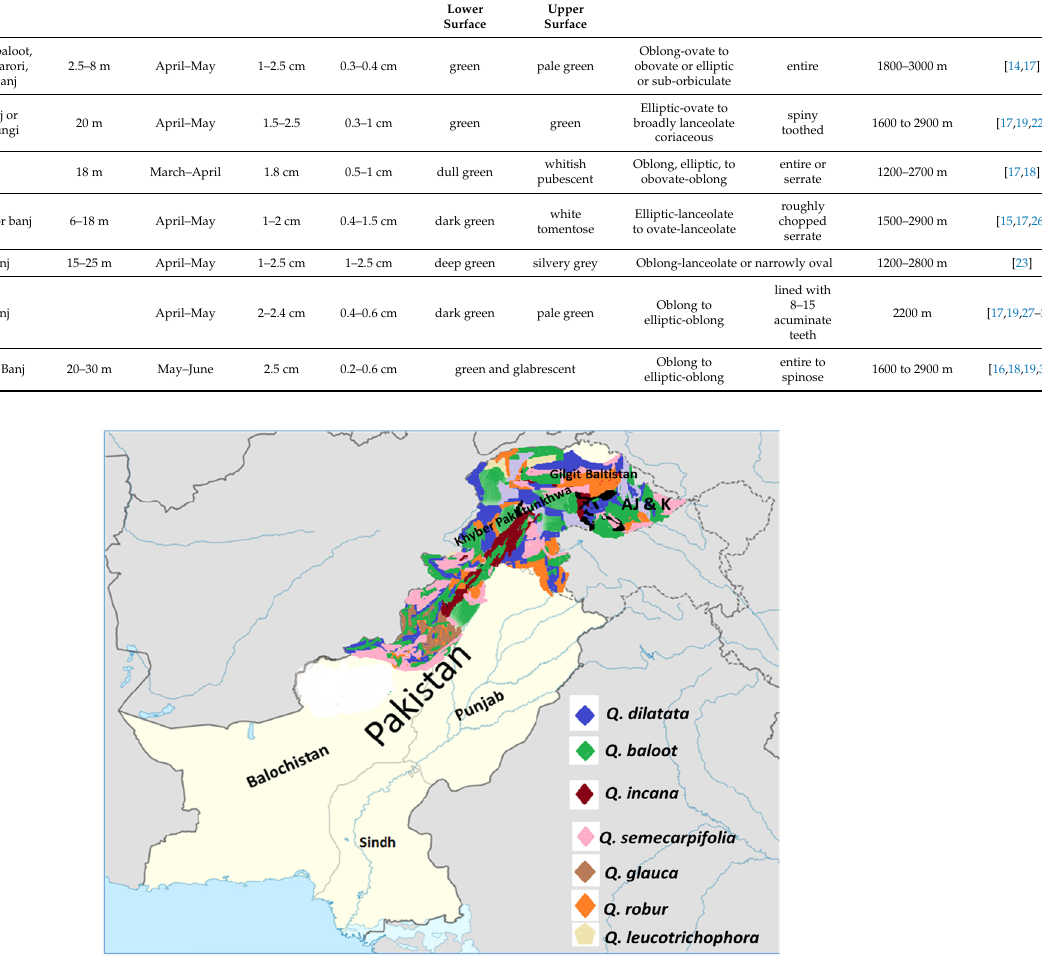
Figure 3. Map of Pakistan representing the localities of Quercus spp.